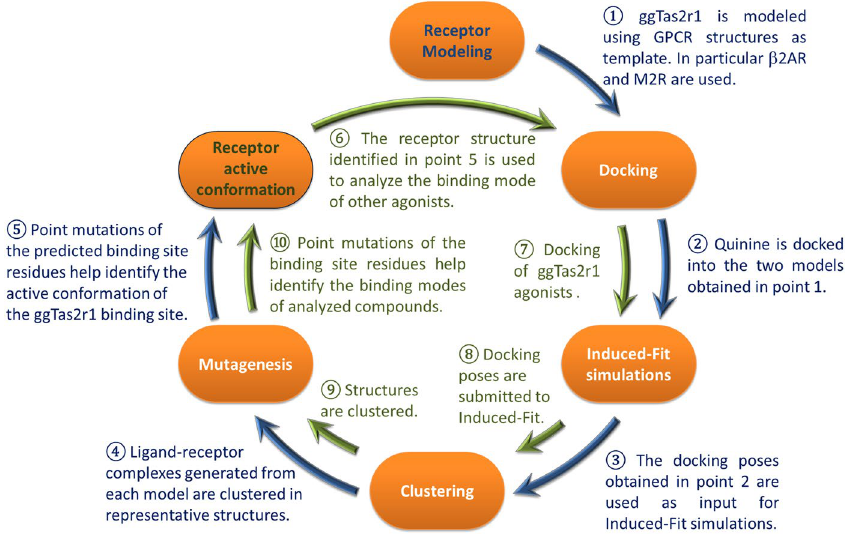
Figure 1. Workflow. The first cycle (blue arrows) led to the investigation of the quinine binding mode and, consequently, the identification of the active conformation of the ggTas2r1 binding site. The second cycle (green arrows) is aimed to identify the binding modes of other ggTas2r1 agonists by using the predicted active conformation. In each cycle, PELE (Protein Energy Landscape Exploration) was used to run Induced-Fit simulations and generate the binding site conformations, while mutagenesis analysis was used to identify and validate the binding